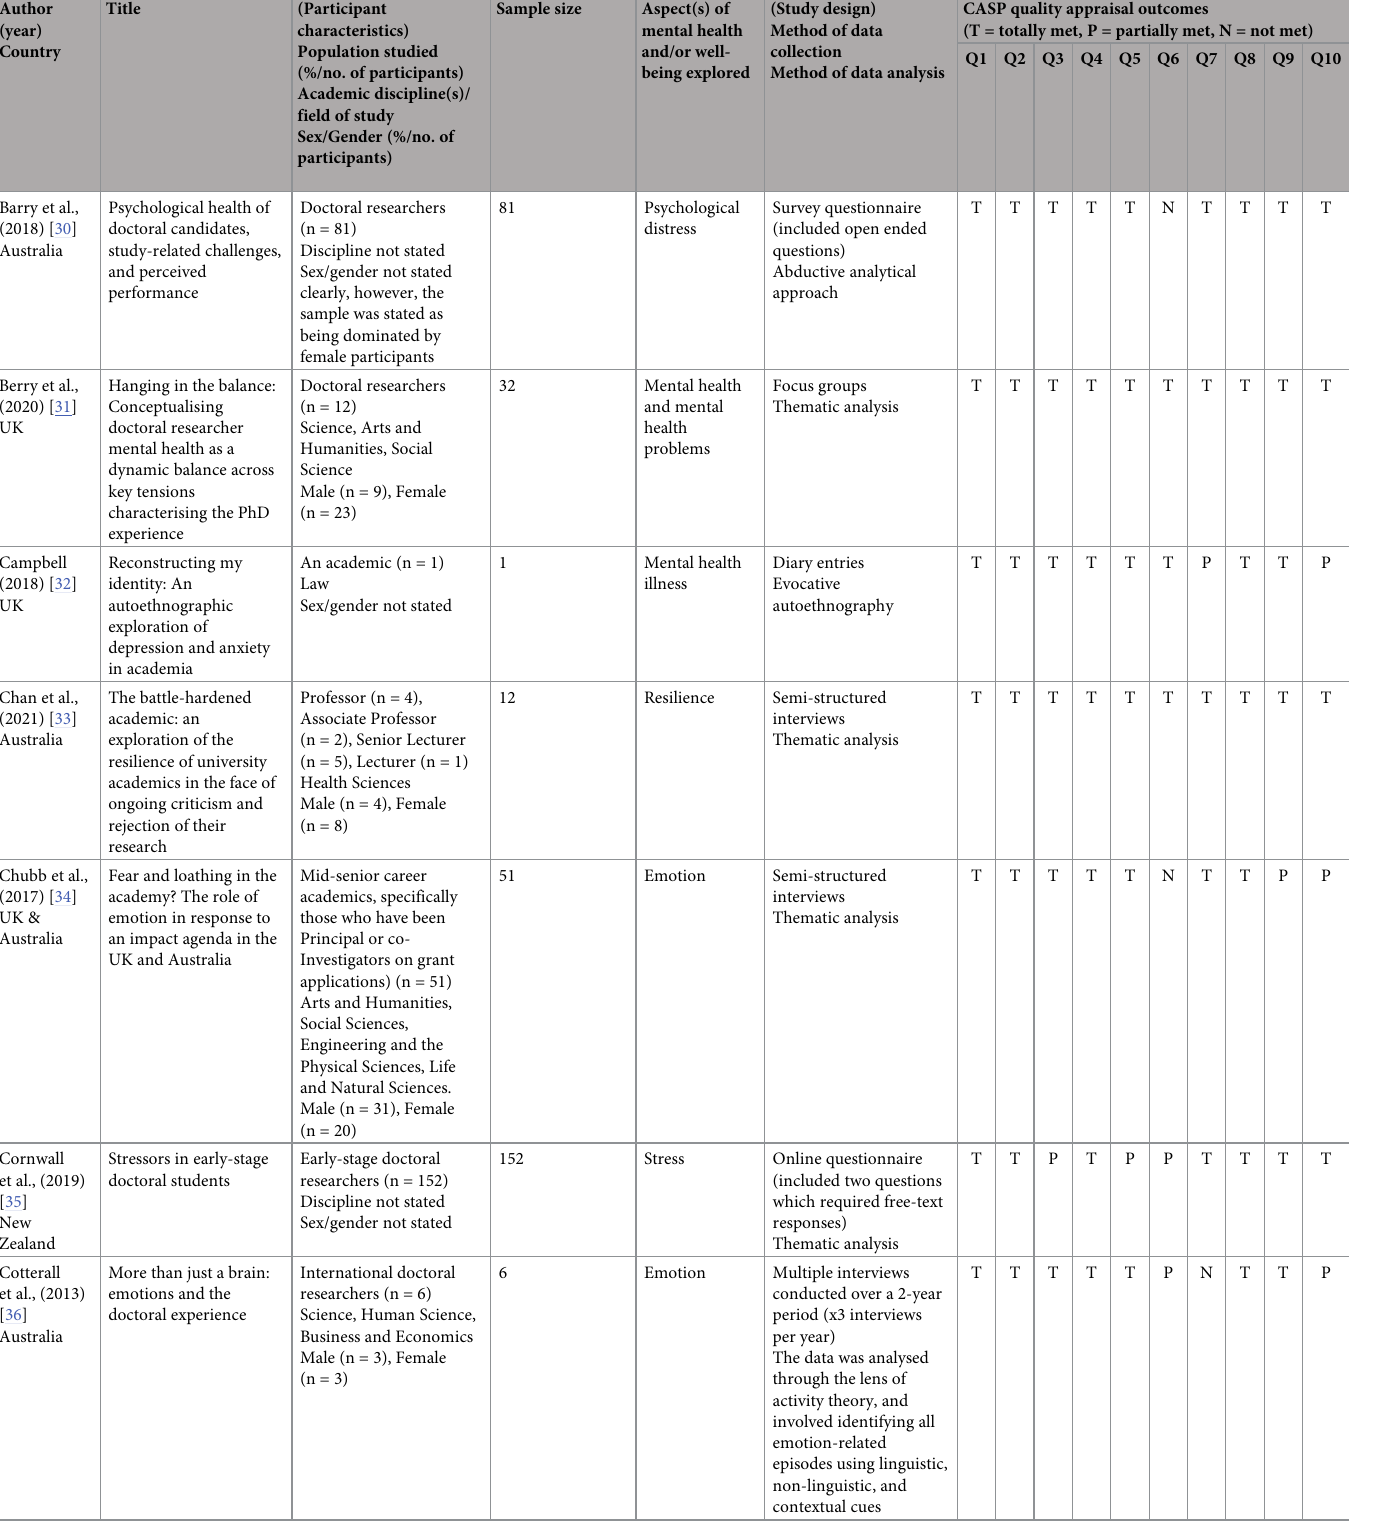
Table 1. Characteristics of the included studies and quality appraisal